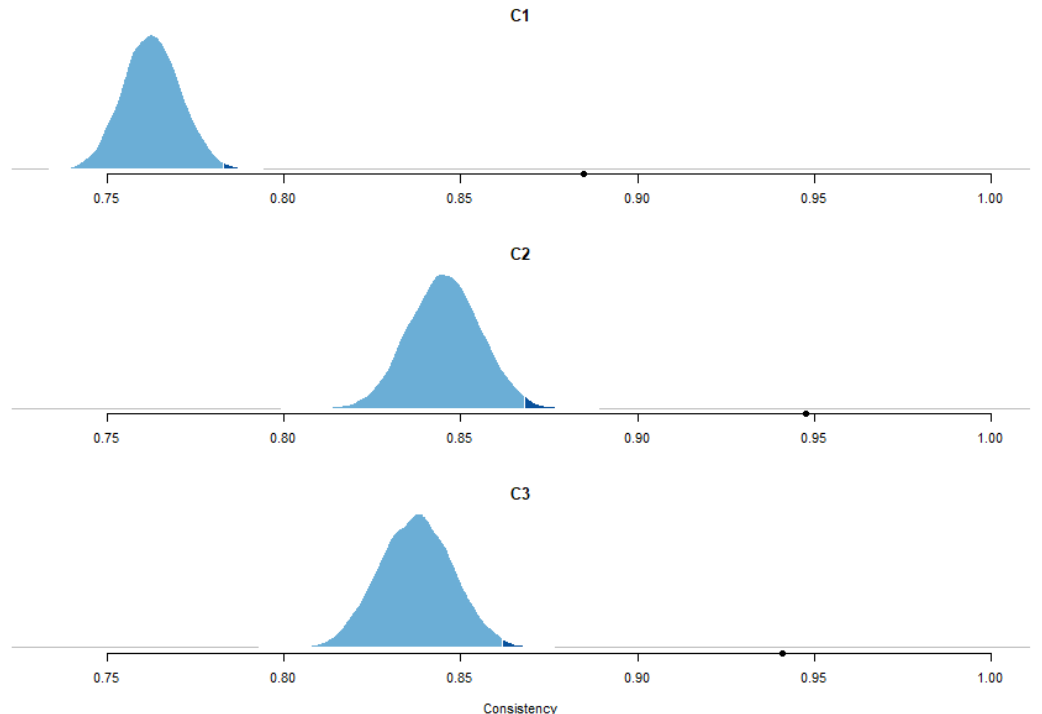
Figure 11. Observed consistencies and consistency distributions based on permutations for low energy consumption efficiency performance. Notes : The permutation test is based on 10,000 replications. C1—~CD × ~HE × ~Gini × ~CR. C2—~FIP × ~CD × GDP × ~HE × ~Gini. C3—~FIP × ~CD × GDP × ~CR × ~Gini. The dots represent the observed consistency scores, and the distributions are the permuted ones.